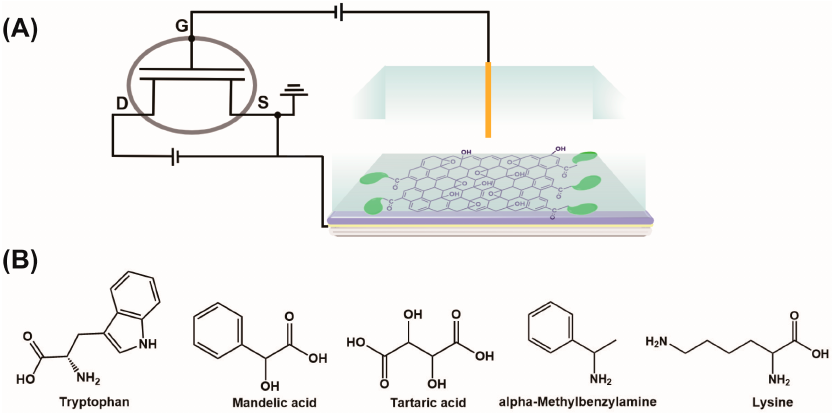
Figure 5. ( A ) Schematic diagram of the Nafion–GO@BSA–EG-MOSFET sensor and ( B ) structures of chiral